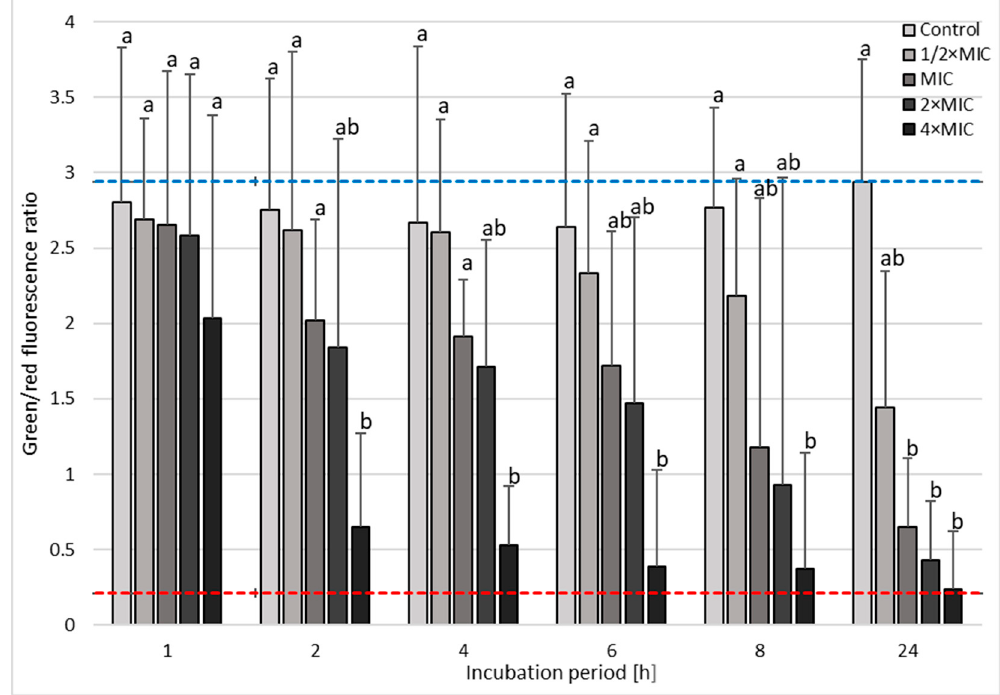
Figure 6. The fluorescence microscopy analysis of the viability during the incubation of H. pylori Tx30a with 3-Bromopyruvate (3-BP) in time. The blue top and red bottom lines indicate the positive (0 h incubation) and negative controls (1 h treatment with 70% ethanol), respectively. Columns with the same subscript letters are not significantly different from each other ( p > 0.05).